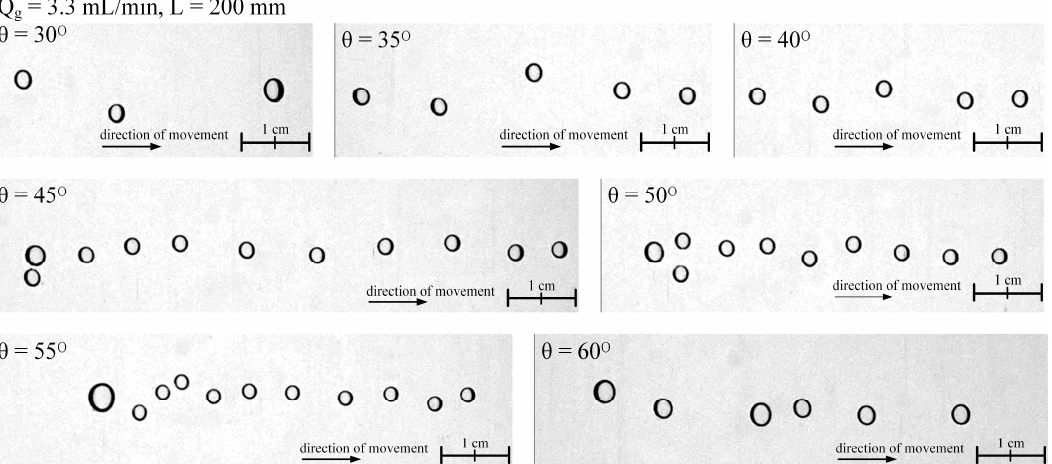
Figure 4. Characteristic images of bubbles. Gas flow rates Q g = 3.3 mL/min; distances from the gas input point to the shooting point L = 200 mm; angle of inclination of the pipe θ = 30°–60°.